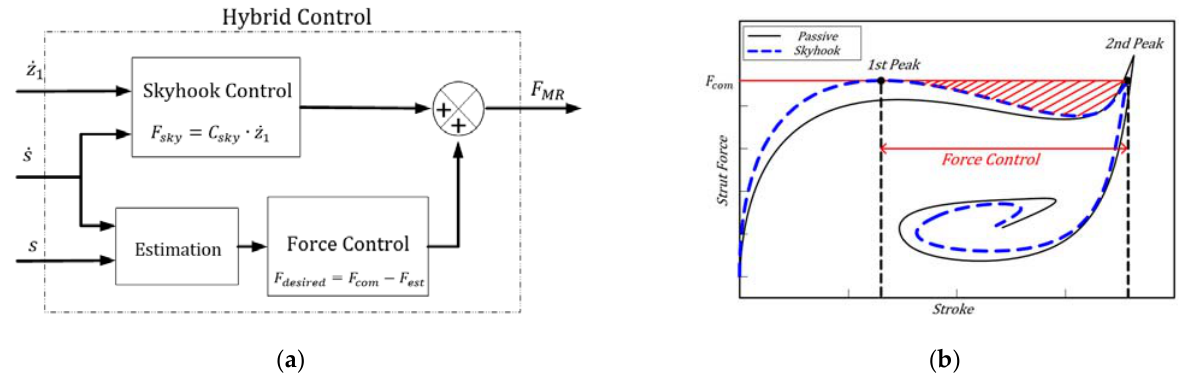
Figure 7. Hybrid control: ( a ) Flow diagram; ( b ) Conceptual diagram of the strut force–stroke curve.